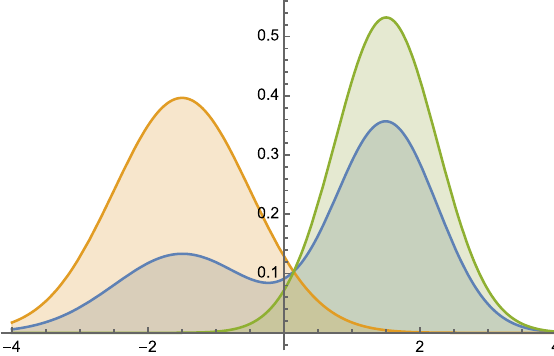
Fig. 5 Example 2: f ( x )/µ (in blue) superimposed on the two pdfs used for MIS